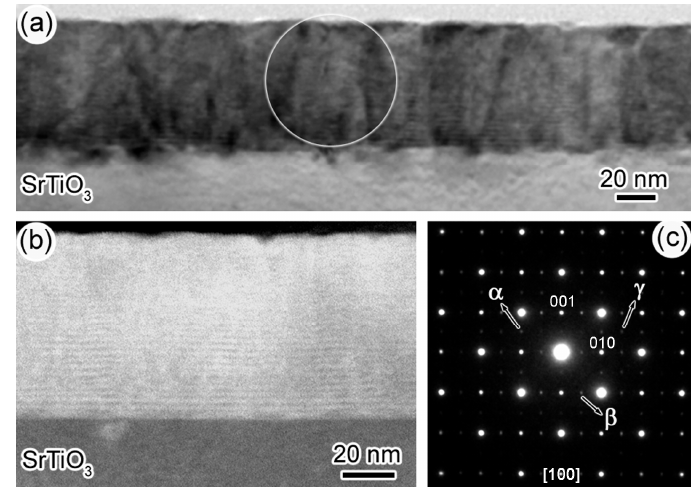
Figure 4. ( a ) The low-magnification TEM image of sample-II; ( b ) The HAADF image of sample-II; ( c ) The SAED pattern of LFO-YMO multilayers. The weak reflection spots coming from three-type domain are highlighted by white arrows.